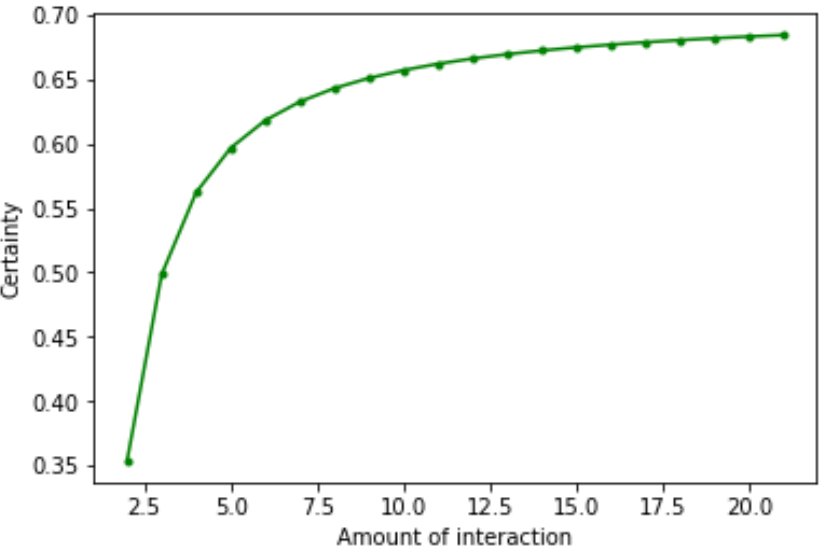
Figure 6. Evidence certainty increases with the amount of interaction ( r + s ) when satisfaction 0.5 is fixed; x -axis: amount of interaction; y -axis: certainty degree.